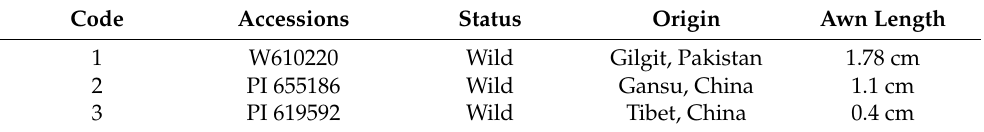
Table 1. E. nutans accessions were used in the present